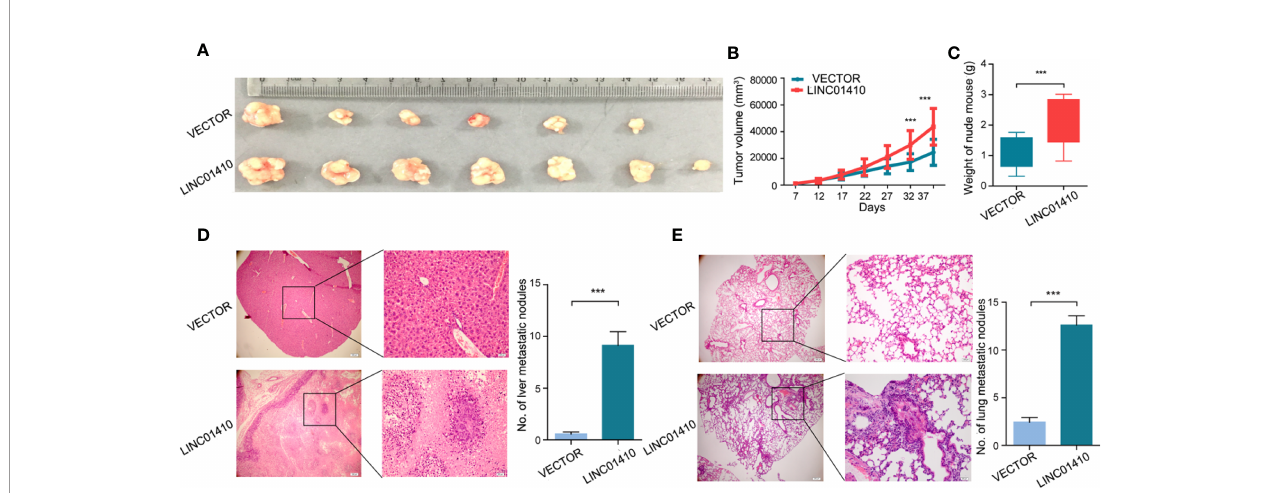
FIGURE 6 | LINC01410 enhanced the development and progression of GBC in vivo . (A – C) The GBC-SD cells with LINC01410-overexpressed lentiviruses and its negative control lentiviruses were injected subcutaneously into nude mice, respectively. The established tumors (A) , tumor growth curves (B) and tumor weights (C) were shown (n = 6). (D, E) LINC01410 over-expressing cells were injected into the spleen of nude mice. Representative microscopic images, and number of liver (D) , and lung (E) metastatic lesions at 6weeks after injection of tumor cells. ***p <